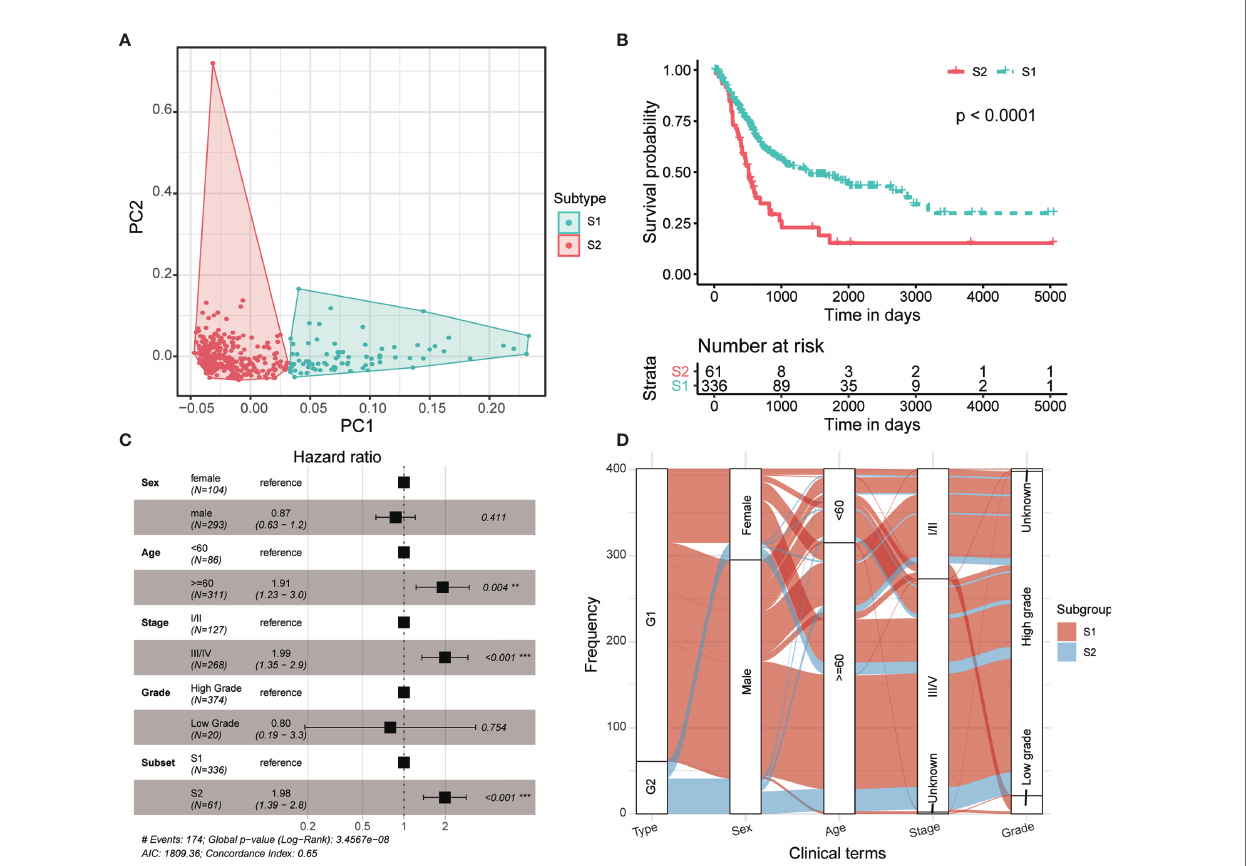
FIGURE 2 | Two prognostic subtypes of MIBC were classi fi ed using multi-omics data-based deep learning framework. (A) Principal component analysis shows two distinguished MIBC subgroups clustered by K-means algorithm. (B) Kaplan-Meier curves show a signi fi cant difference of overall survival between MIBC subtypes. (C) Forest plot shows the multi-variates cox regression analysis result using general clinical characters as well as the predicted MIBC subtypes. (D) Distribution of the MIBC subtypes in various clinical